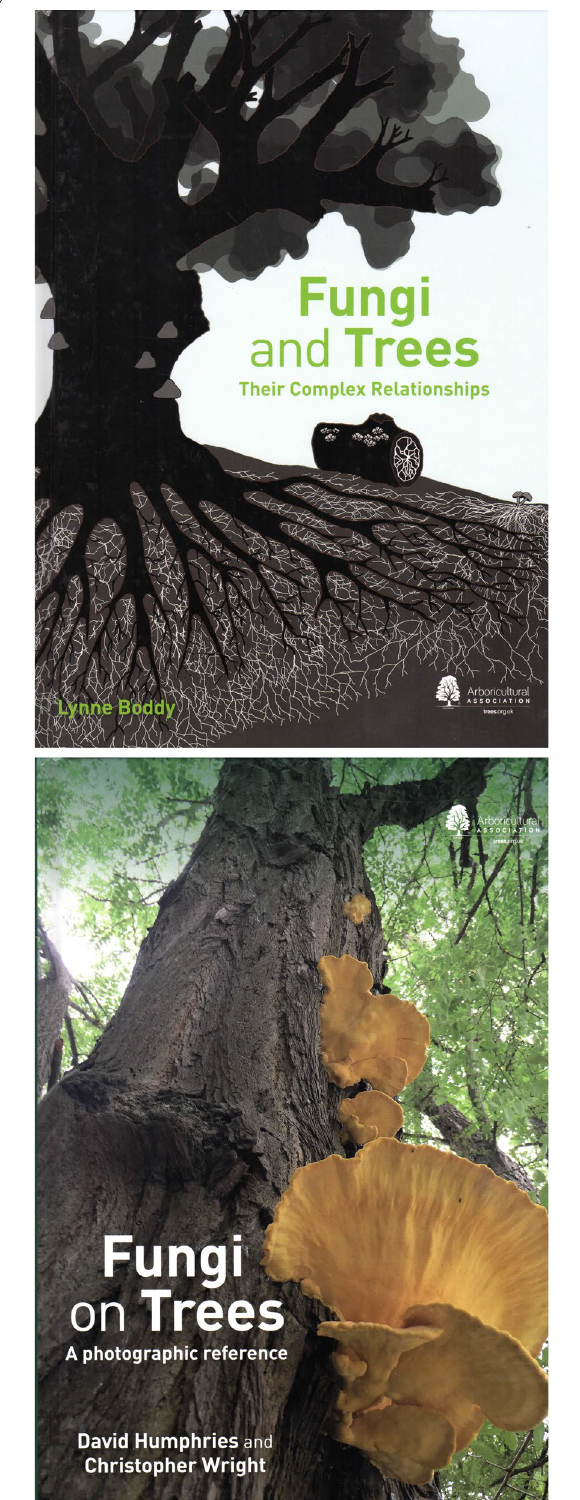
Fig. 30 Fungi and Trees and Fungi on Trees